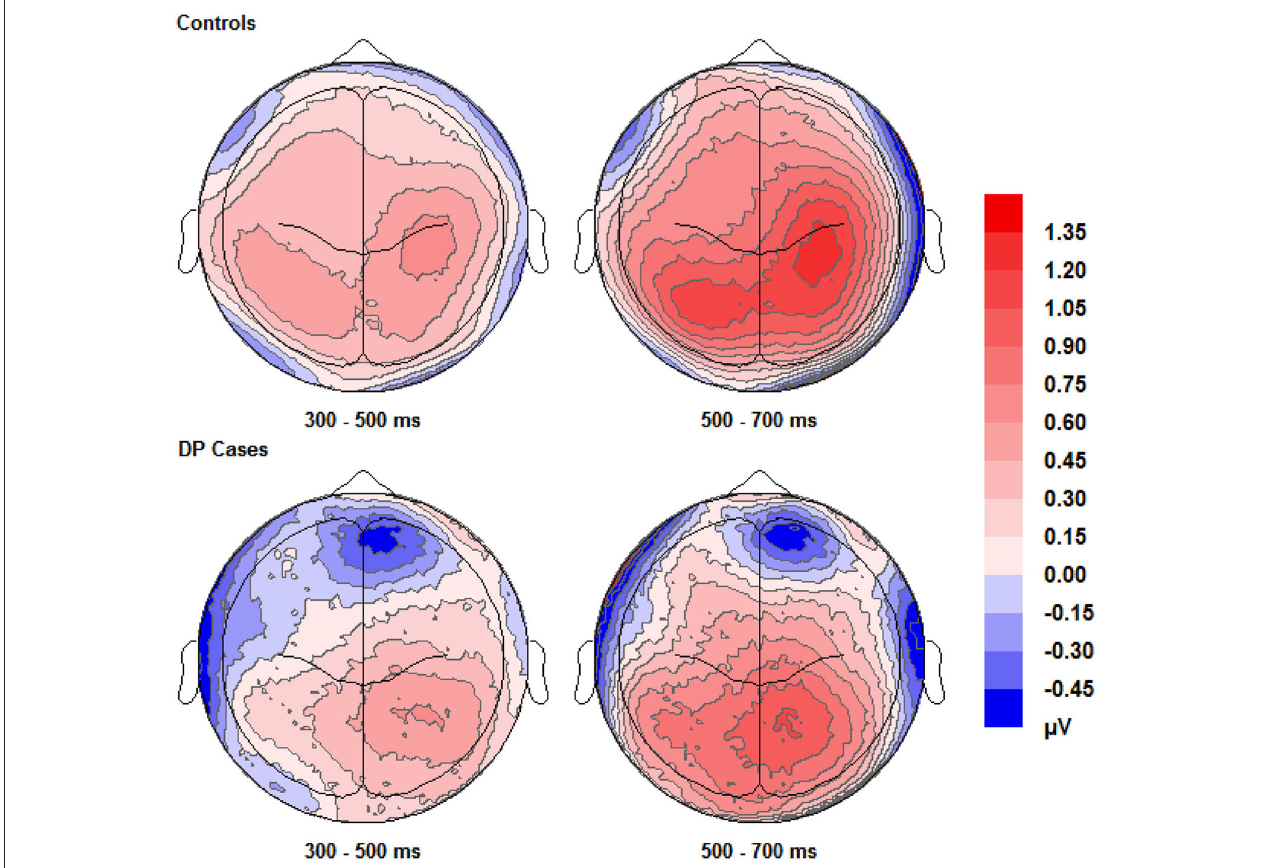
FIGURE 4 | Scalp maps (shown as if viewing from above the head) for the voltage corresponding to correct “remember” responses minus that for correct rejections . Data for both groups and time intervals are shown across the four